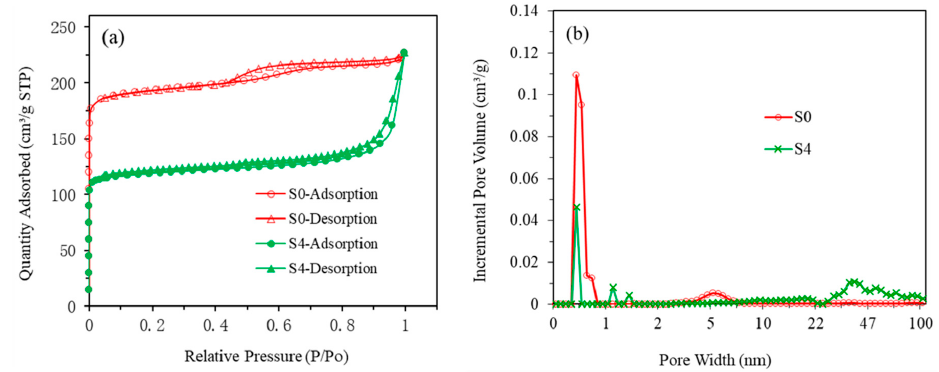
Figure 5. The adsorption of N 2 ( a ) and the pore size distribution curve ( b ) of samples (S0 and S4).